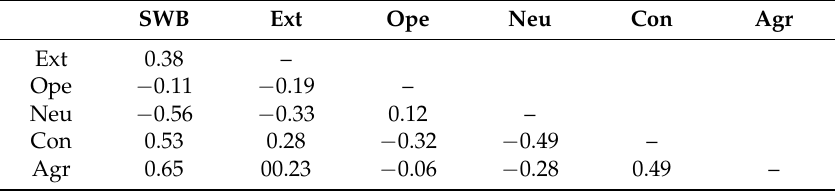
Table A5. Correlations between variables for the machine learning-derived scores ( n =